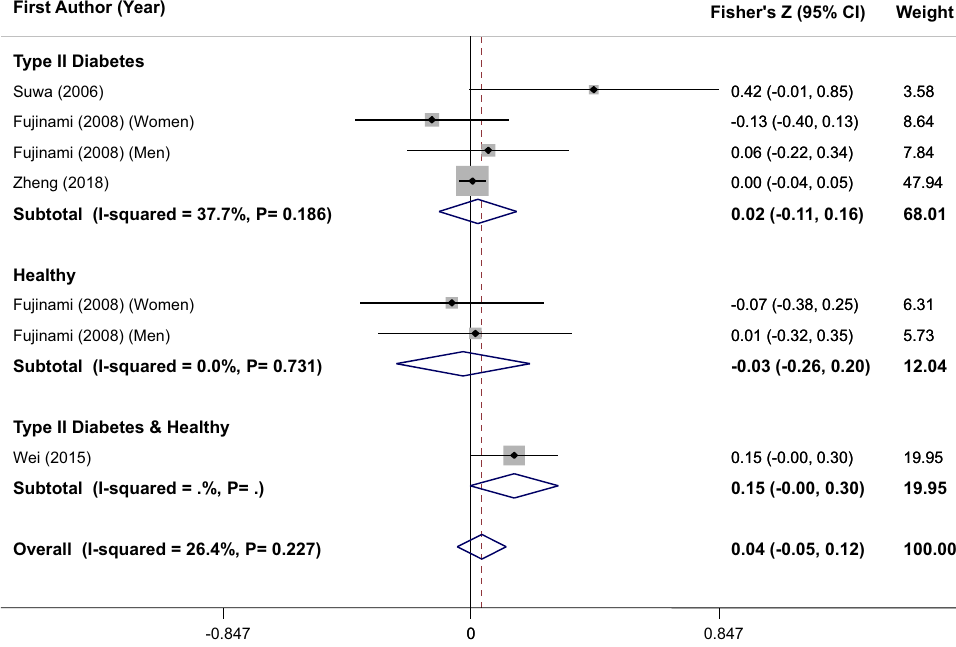
Figure 5. Forest plot of correlation between serum/plasma BDNF levels and glycated haemoglobin (HbA1C); stratified by health status of